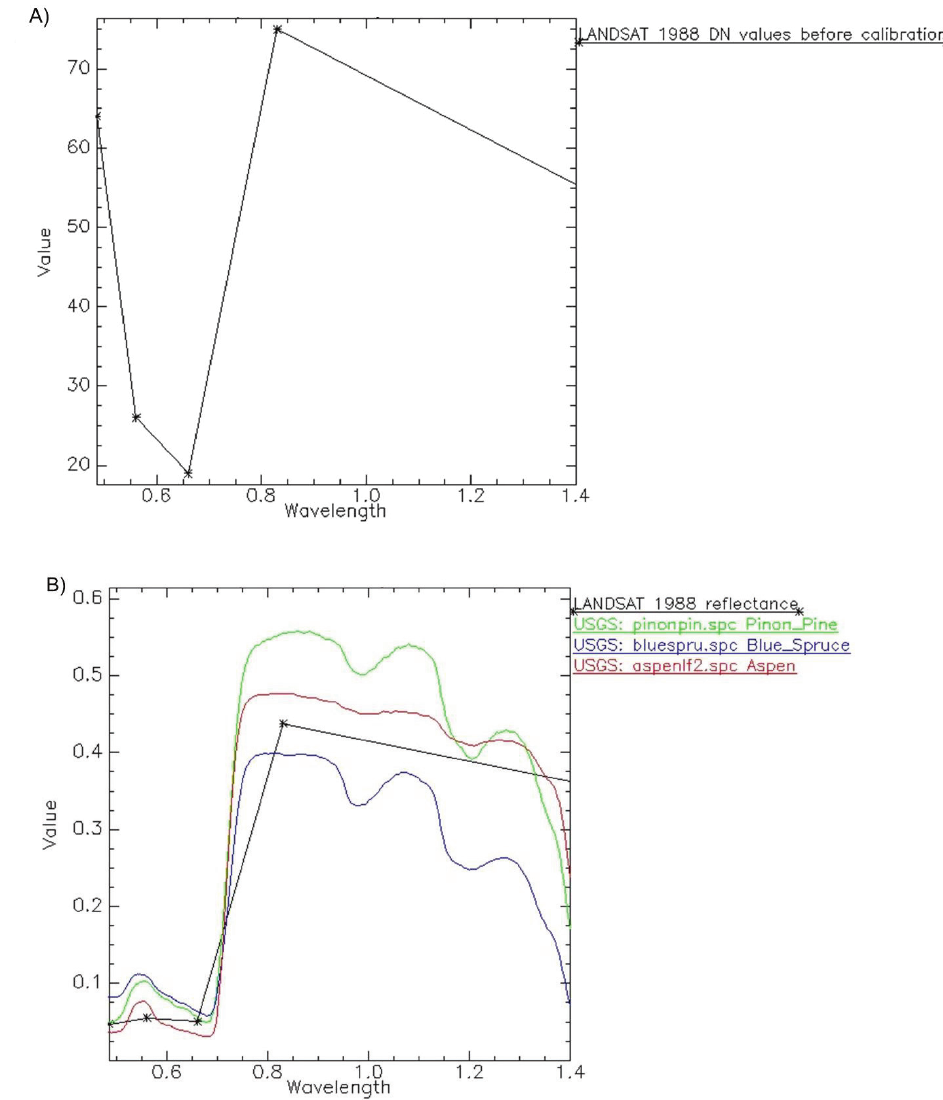
Figure 12. ( A) Example of LANDSAT TM radiance (VIS and VNIR spectral region) of a vegetation image end member. (B) LANDSAT TM reflectance (VIS and VNIR spectral region) of the same vegetation image end member as in (A) compared to the reflectance from the USGS vegetation